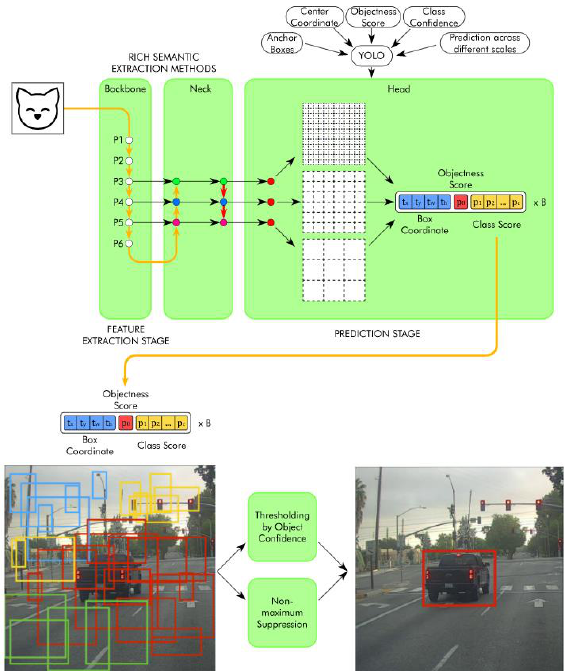
Figure 23. YOLO architecture and how it works (Adapted from [33,34]).